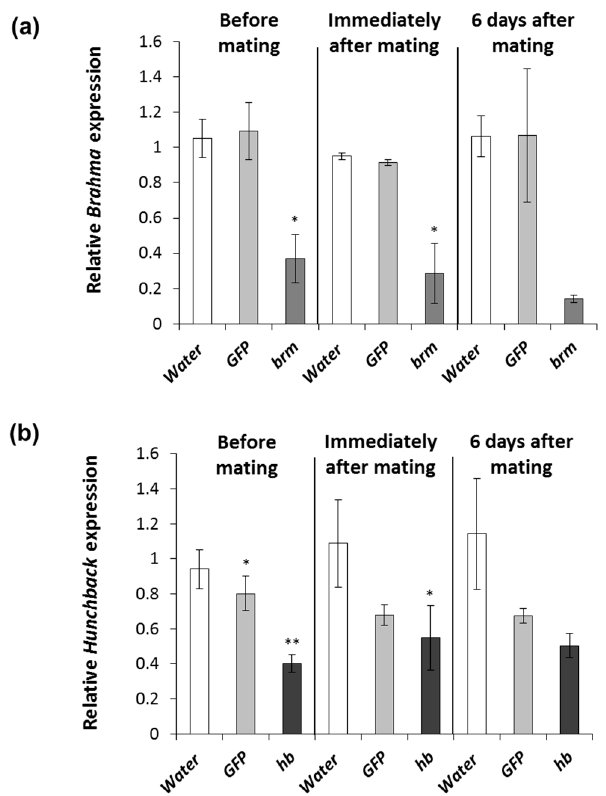
Figure 4. Relative transcript level of brahma ( brm ) and hunchback ( hb ) in D. v. virgifera females : ( a ) relative brahma transcript expression for timing of exposure; and ( b ) relative hunchback transcript expression from timing of exposure. Comparisons performed with Dunnett ′ s test (control group = water), * significance at p < 0.05. ** significance at p < 0.001.